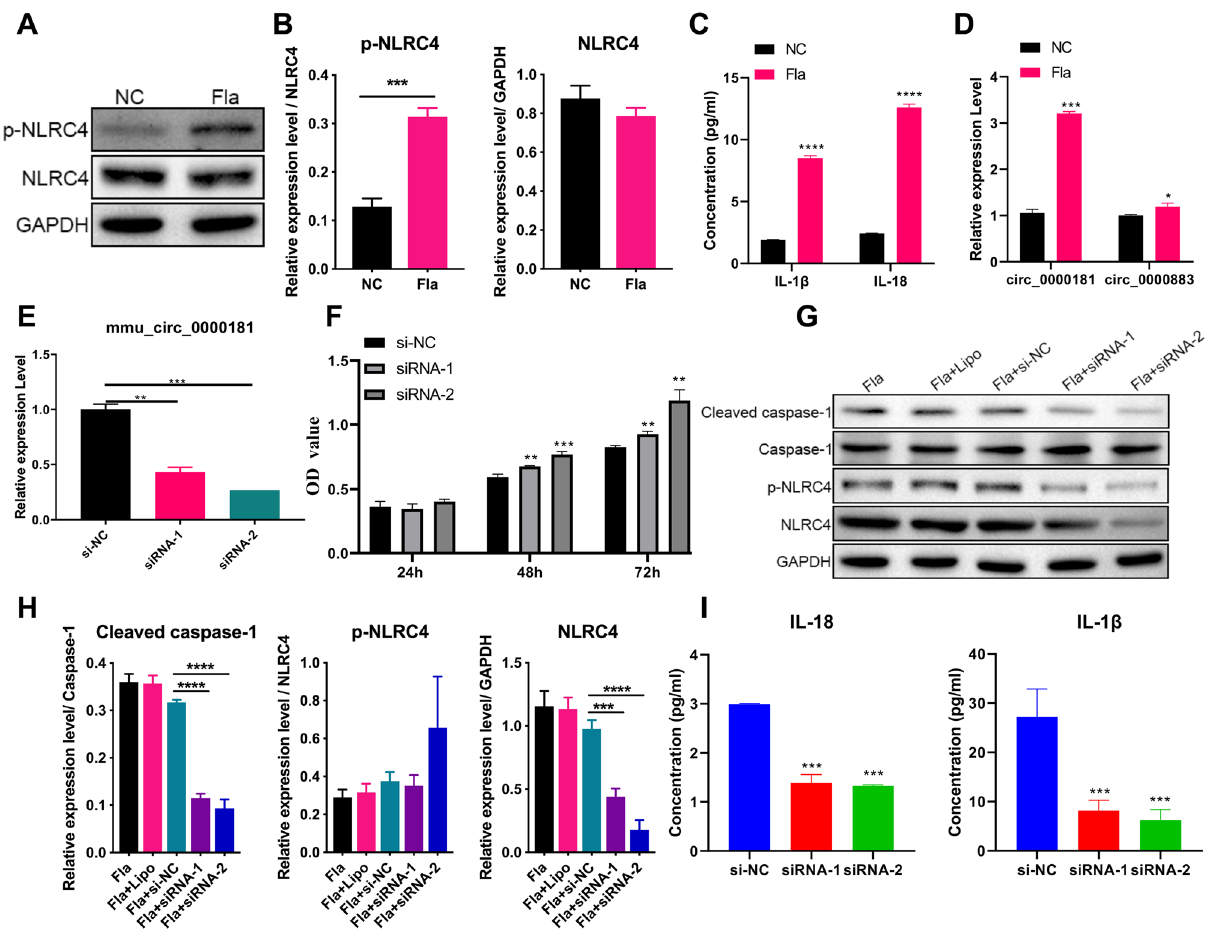
Figure 4. circ_0000181 is involved in NLRC4-induced pyroptosis of MRTEC cells. ( A ) The expression of NLRC4 and p-NLRC4 in MRTEC cells with or without Fla stimulation was detected using WB. The origianl images were cut prior to hybridisation with antibodies during blotting. ( B ) Proteins were quantified based on the gray values of WB results. ( C ) The concentration of IL-1β and IL-18 in MRTEC cells supernatant with and without Fla stimulation (activation for 6 h) was detected using ELISA analysis. ( D ) qPCR analysis was used to measure circ_0000181 and circ_0000883 expression in MRTEC cells with and without Fla stimulation (activation for 6 h). ( E ) qPCR analysis was used to detect circ_0000181 expression under different siRNA interference (Fla activation for 6 h after transfection 48 h). ( F ) Cell proliferation ability was detected using MTS in MRTEC cells with Fla stimulation after transfection with circ_0000181 siRNAs for 48 h. ( G ) The WB analysis was used to detect the expression of NLRC4, p-NLRC4, and Casepase1 in MRTEC cells with Fla stimulation under different siRNA interference. The origianl images were cut prior to hybridisation with antibodies during blotting. ( H ) Quantitative analysis of protein in line with WB data. ( I ) The ELISA analysis was used to determine the secretion of IL-1β and IL-18 in MRTEC cells with Fla stimulation under different siRNA interference. ** P < 0.01; *** P < 0.001; *** P < 0.0001. Data are presented as the means ± SD from three independent